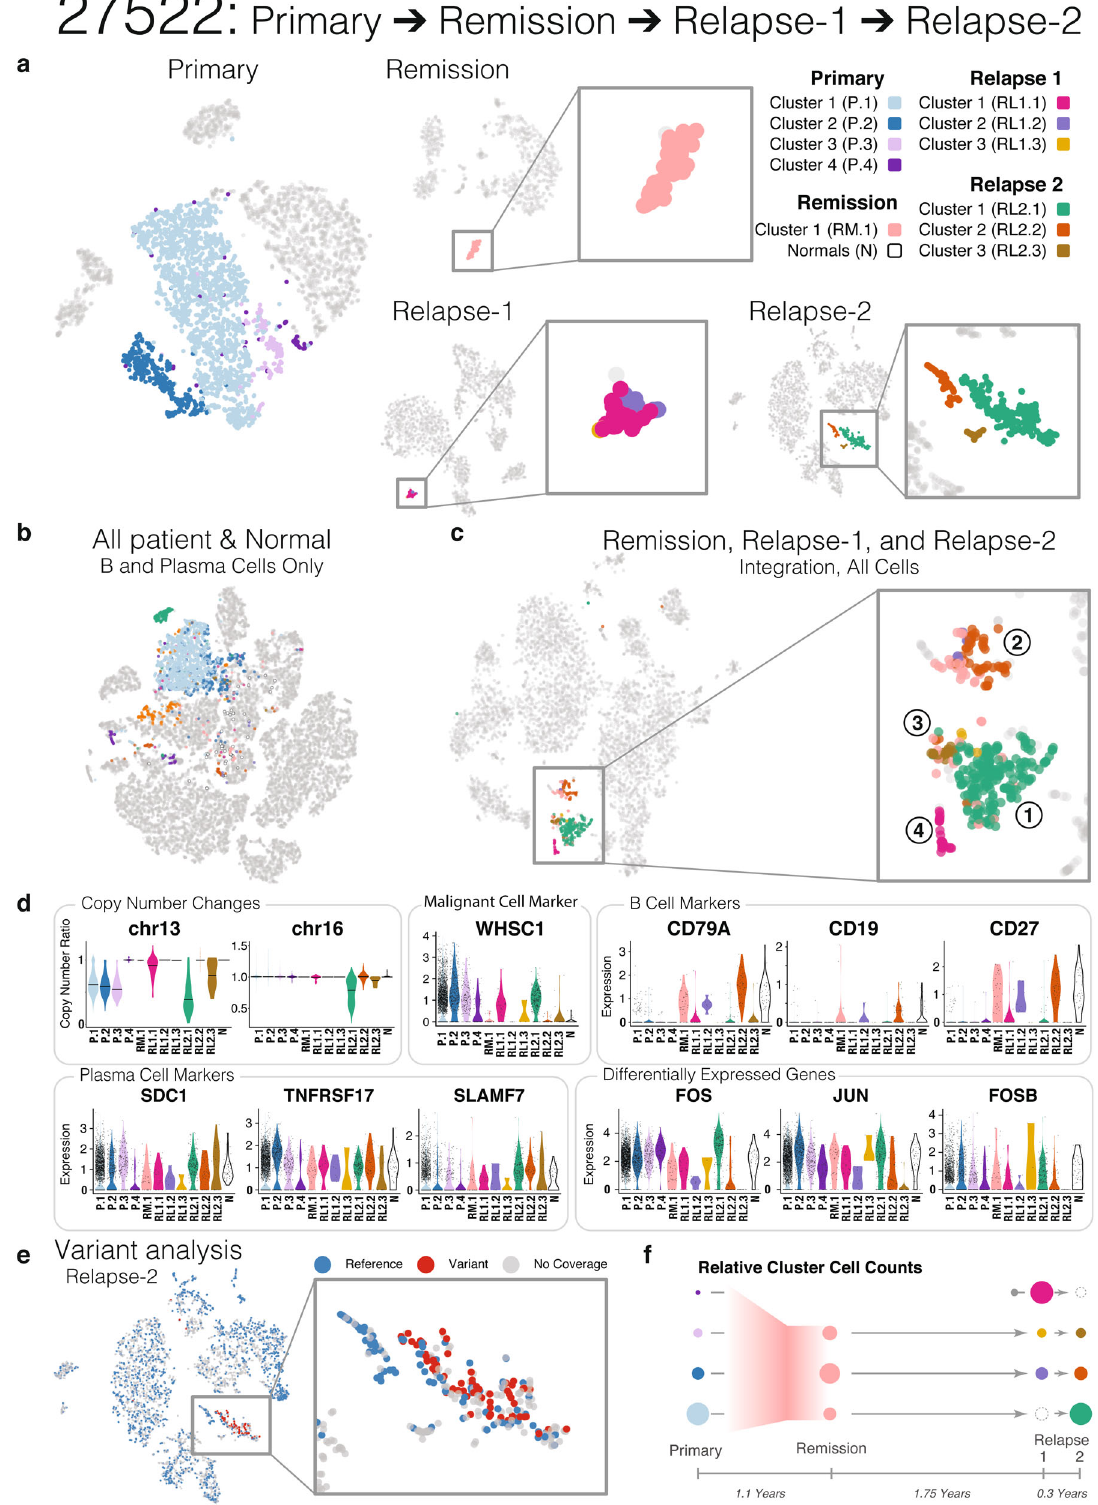
Fig. 5 Detailed analysis of plasma cell subpopulation shift for Patient 27522. a t-SNE mapping of plasma cell subclusters for Patient 27522 at Primary, Remission, Relapse-1, and Relapse-2 disease stages. Colors indicate different subclusters within each time point. b Plasma cell subclusters identi fi ed in a mapped to the integrated t-SNE of b and plasma cells from all samples plus healthy donors (as in Fig. 3a). c Plasma cell subclusters identi fi ed in a mapped to the integrated t-SNE of all cells from Patient 27522 Remission, Relapse-1, and Relapse-2 disease stages. d Subcluster level copy number changes and expression of malignant cell markers, B cell markers, plasma cell markers, and differentially expressed genes. e Somatic mutations mapped onto Relapse-2 t-SNE (blue, reference allele only; red, variant allele detected; grey, no coverage). f Possible explanation for plasma cell subpopulation shift from Primary to